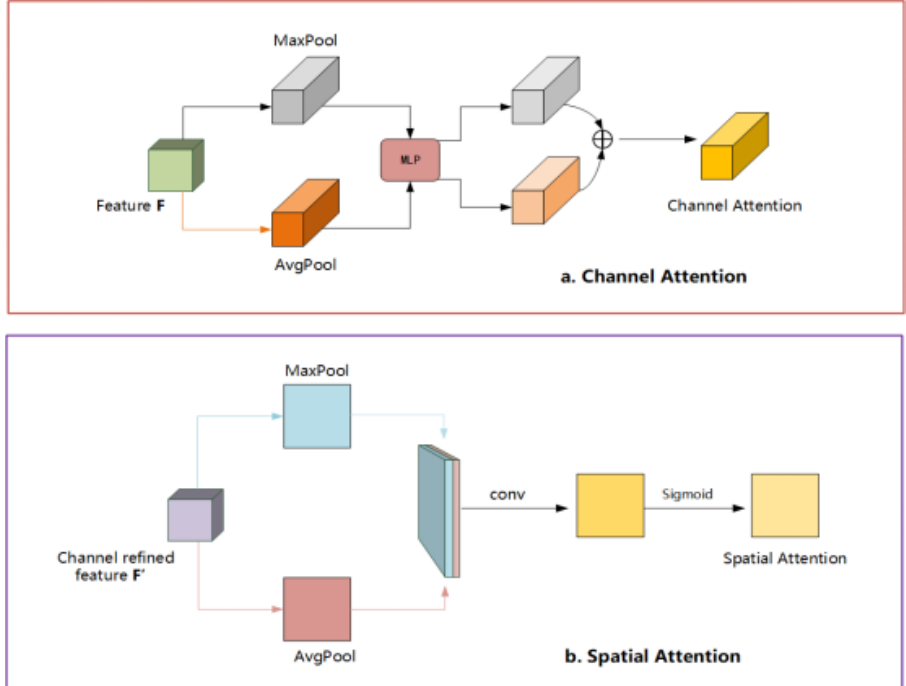
Figure 4. The overall structure of dual attention (( a ). Channel Attention; ( b ). Spatial